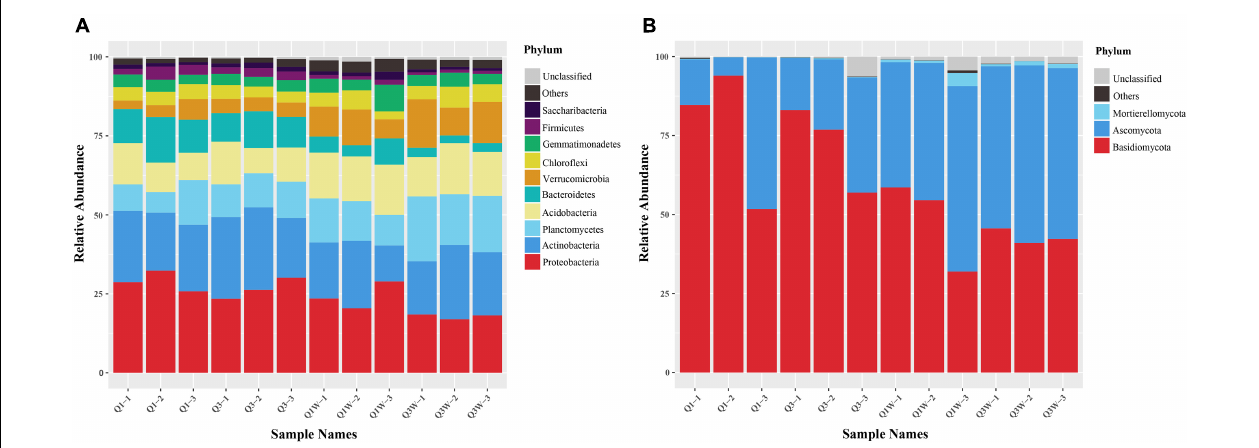
FIGURE 2 | Relative abundance of bacteria and fungi in phylum level. Weighted UniFrac UPGMA tree based on V3-V4 16S rRNA gene of bacteria and ITS2 DNA sequences of fungi obtained from 12 different samples related with fairy rings OUT zone and ON zone. (A) bacteria; (B) fungi.